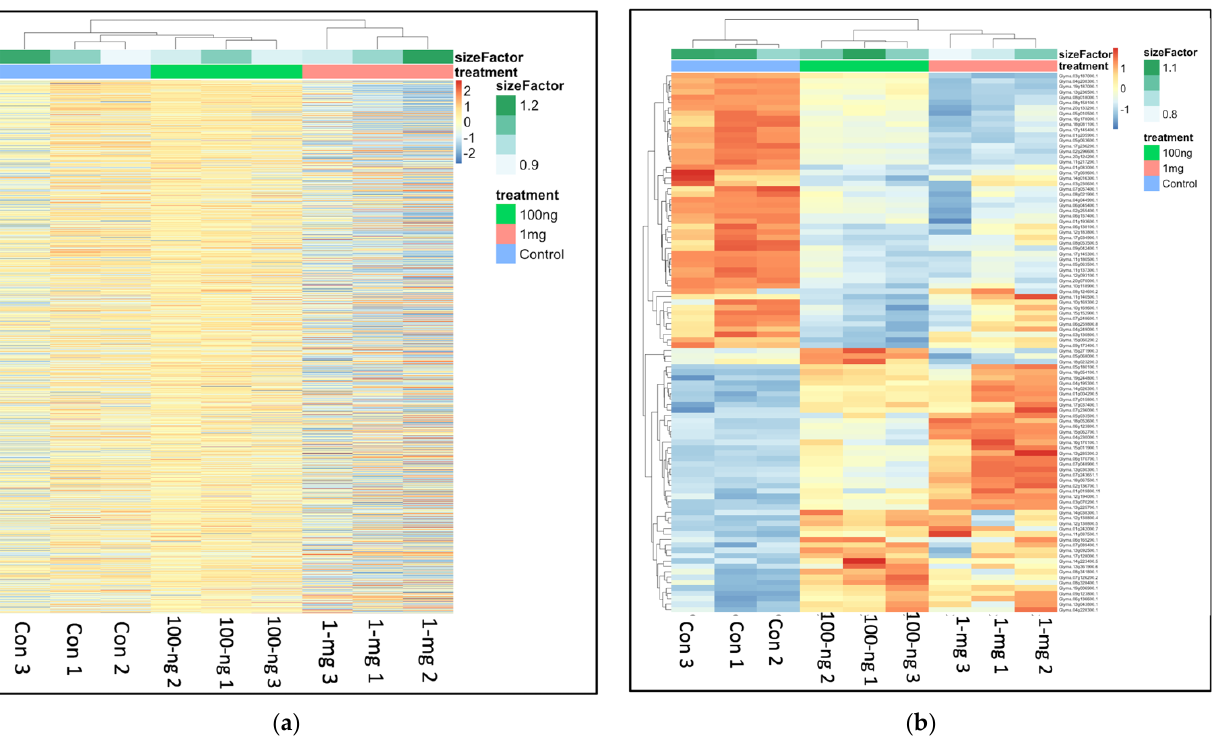
Figure 6. Clustering profile of ( a ) top 1000 expressed genes of the control, 100 ng/L and 1 mg/L groups ( n = 3). The clustering showed that the replicates in each group clustered more within the group than with the other groups ( b ) top 100 differentially expressed genes (DEGs) across the control, 100 ng/L and 1 mg/L groups based on the DESeq2 output of 100 ng/L vs. control DE analysis ( p < 0.05 and log 2 -fold change > 1 and transcript read count > 2000).